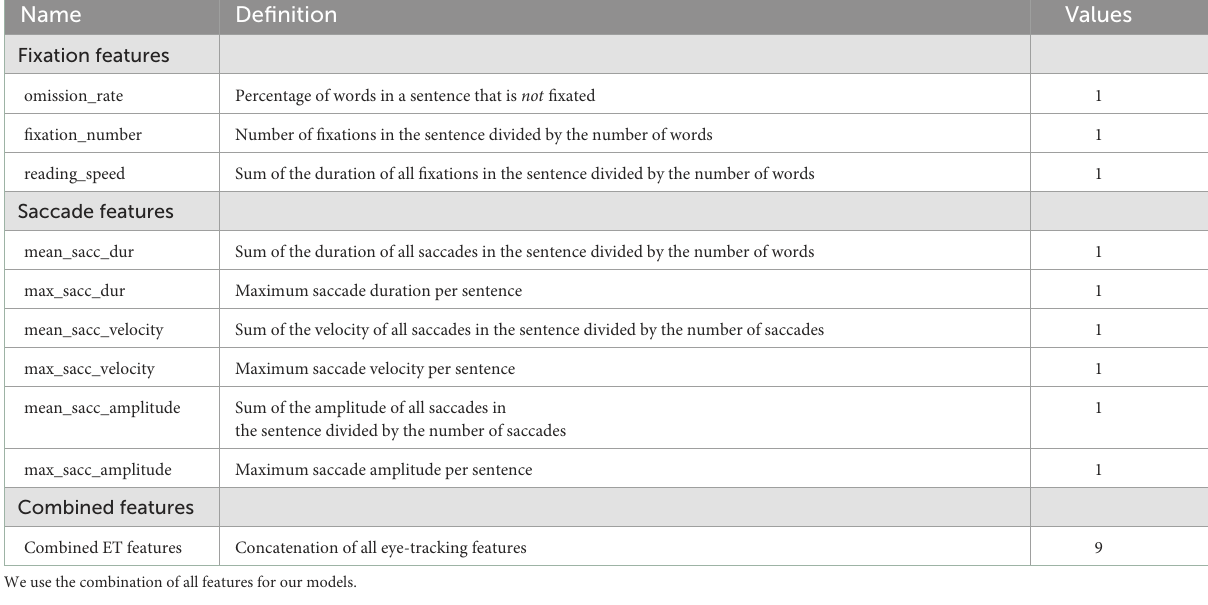
TABLE 6 Sentence-level EEG